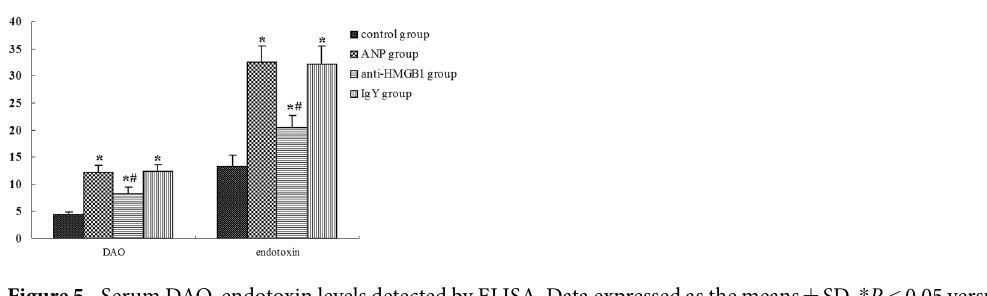
Figure 5. Serum DAO, endotoxin levels detected by ELISA. Data expressed as the means ± SD. * P < 0.05 versus control group. # P < 0.05 versus ANP